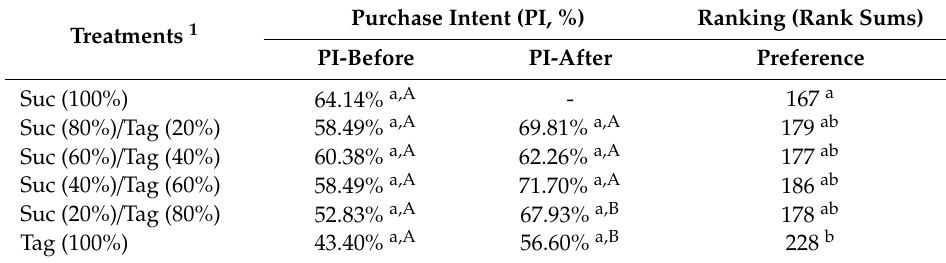
Table 5. Purchase intent and ranking sums of the strawberry-flavored yogurt